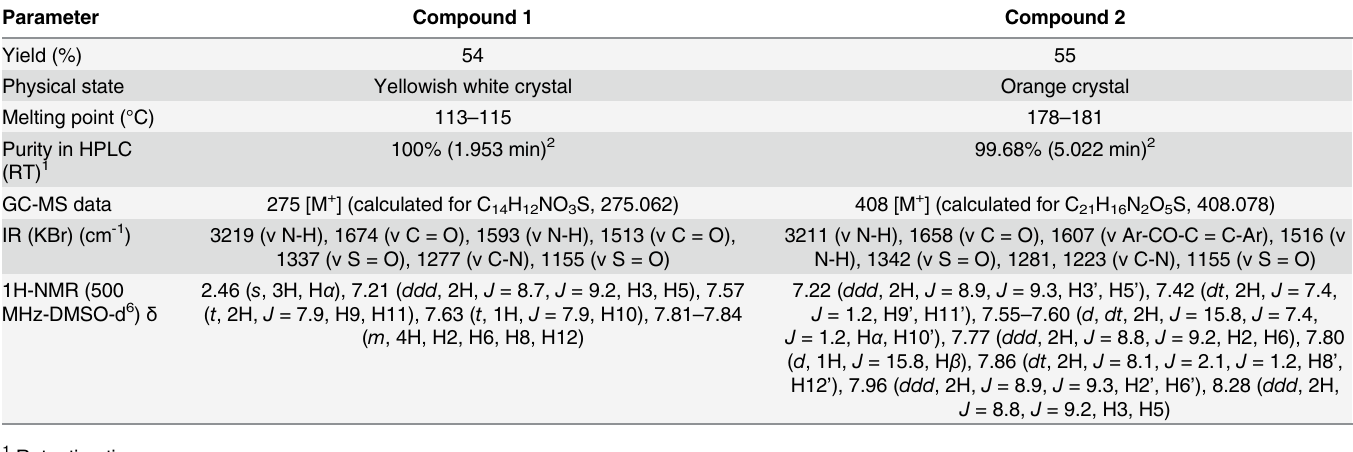
Table 1. Yield, physical state, melting point, purity, and spectroscopic data (GS-MS, IR, 1 H-NMR) of N-(4-acetylphenyl)benzenesulfonamide (1) and N-{4-[( E )-3-(4-nitrophenyl)prop-2-enoyl]phenyl}-benzenesulfonamide